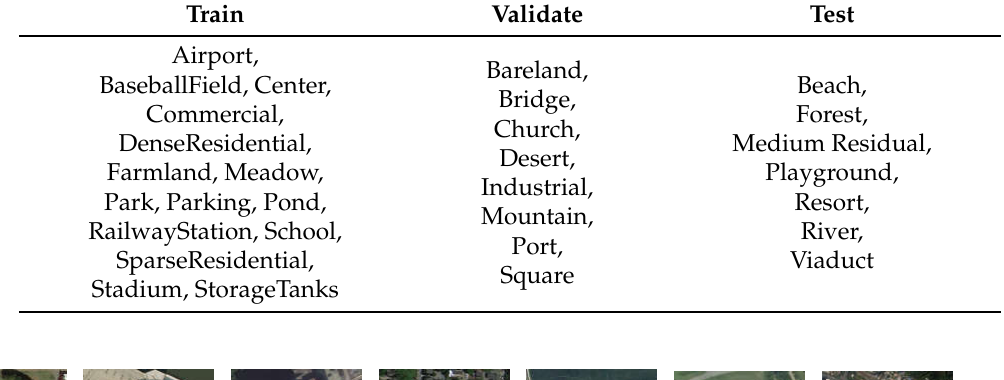
Table 3. Class segmentation for the AID dataset.